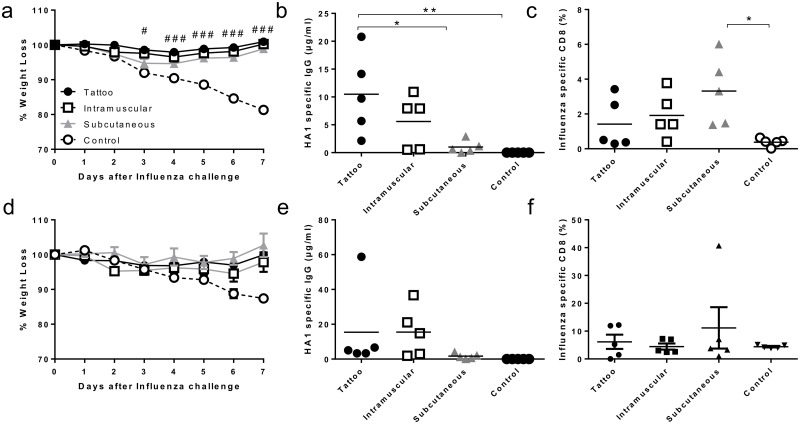
Comparison of immunogenicity after DNA by various routes.5μg DNA encoding H1 haemagglutinin was delivered by the i.m., s.c. or tattooing routes on days 0 and 14. On day 28, mice were infected with 5x105 H1N1 influenza in 100μL intranasally. Weight loss was monitored following infection (a), serum HA1 specific IgG (b), and lung influenza specific (pentamer stained) CD8+ T cells (c) were measured on day 7 after infection. In a subsequent study, mice were immunised with 5μg DNA encoding H1 haemagglutinin delivered by the i.m., s.c. or tattooing routes on days 0 and were infected on day 14 with 5x105 H1N1 influenza in 100μl intranasally. Weight loss was monitored following infection (d), serum HA1 specific IgG (e), and lung influenza specific (pentamer stained) CD8+ T cells (f) were measured on day 7 after infection. Points represent n = 5 animals +/- SEM (a) or individuals (b, c) +/- SEM. # p<0.05, ### p<0.001 between control and other groups analysed by 2 way ANOVA (a), * p<0.05, ** p<0.001 as indicated, analysed by one way ANOVA and post test (b, c).